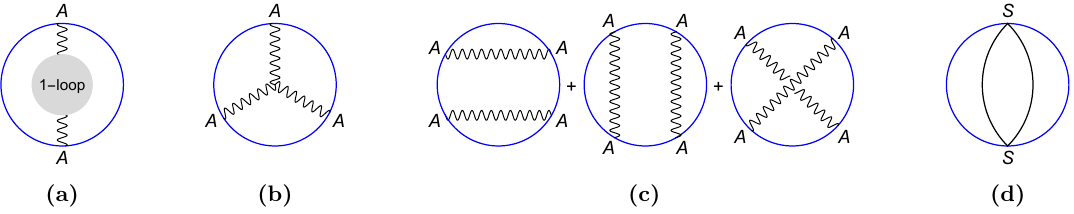
Figure 4. Two-loop Feynman diagrams for h W bos i f . Here S stays for the scalar bilinears which arise from (cid:27) ( a ) , a = 1 ; 2 ; (cid:1) (cid:1) (cid:1) ; n in L bos when we use equations of motion (2.5).